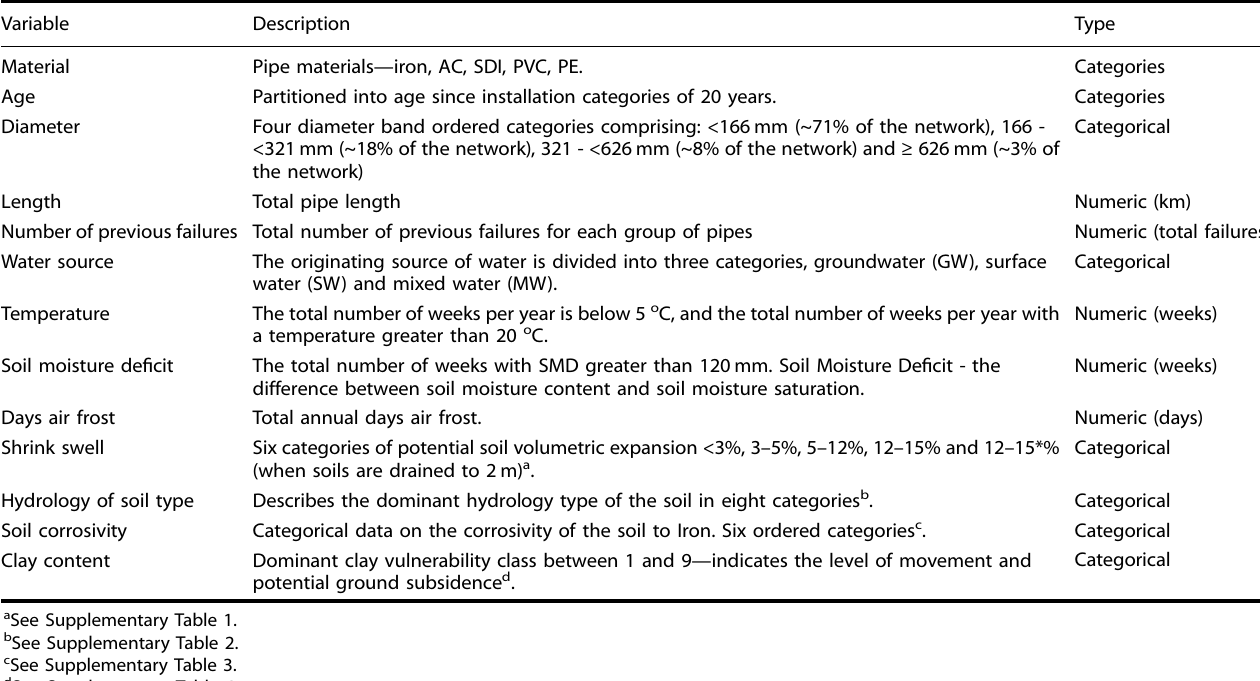
Table 4. Variables selected for the pipe failure model, including description and data